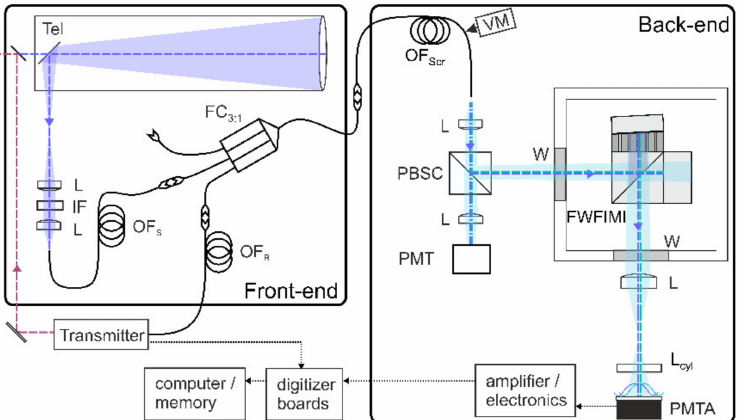
Figure 5. Synopsis of the two subsystems of the DWL receiver. ( Left ): Telescope with fiber insertion and combination (front-end). ( Right ): Spectral analyzer receiver back-end with collimation (out of square-core fiber), polarization selection, interferometer illumination (within thermalized housing) and imaging onto detector PMTA. Acronyms in the